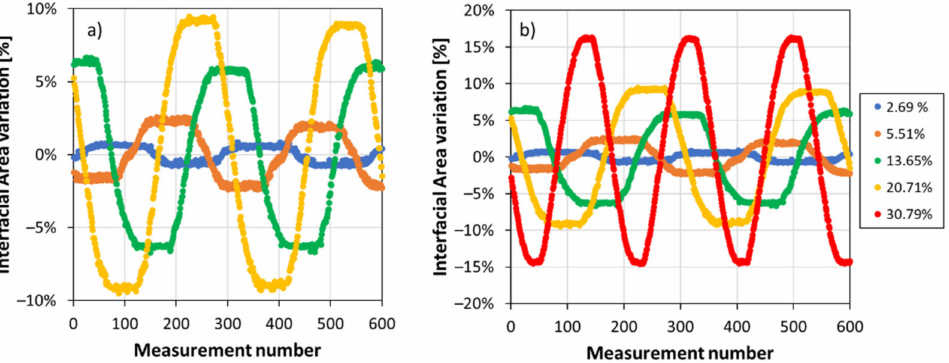
Figure 7. Effect of the motor backlash as a function of the interfacial area amplitude. ( a ) Interfacial area for variations of 2.69%, 5.51%, 13.65% and 20.71% of the average interfacial area (18 mm 2 ), and ( b ) same data including an interfacial area variation of 30.79% (average IA = 38 mm 2